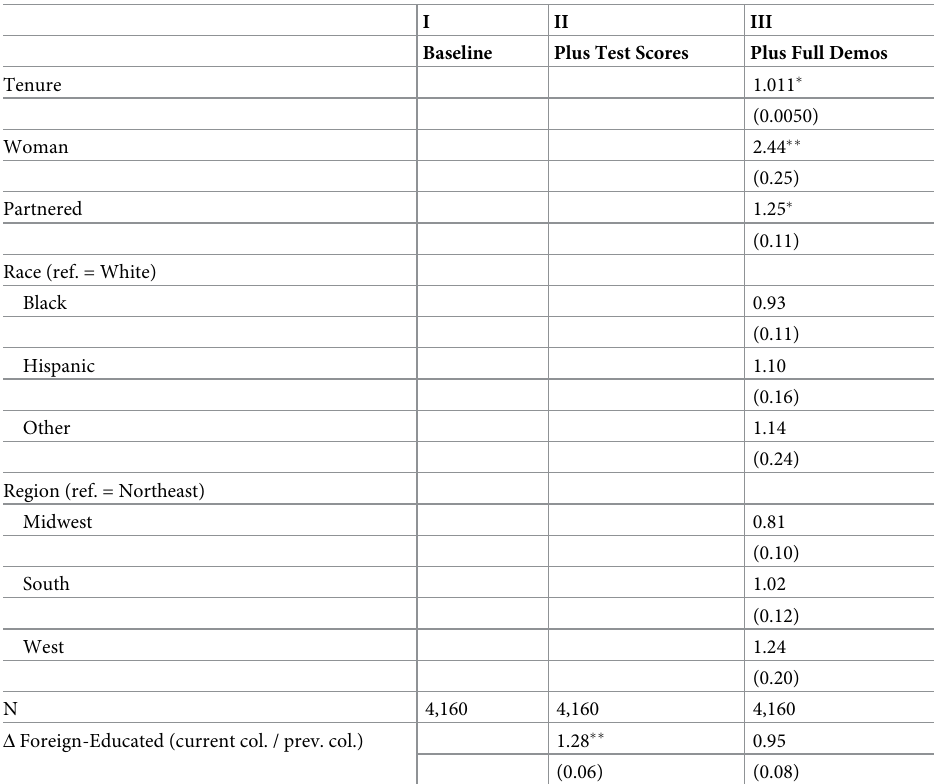
sets of worker characteristics. The skill requirements are grouped into four categories: elementary , semi-skilled blue- collar , semi-skilled white collar , and skilled . Standard errors are in parentheses.